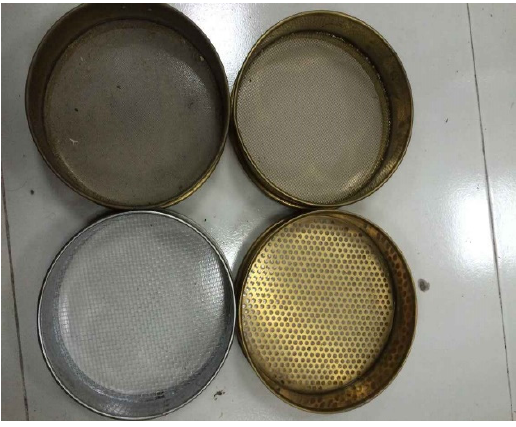
Figure 1. The circular